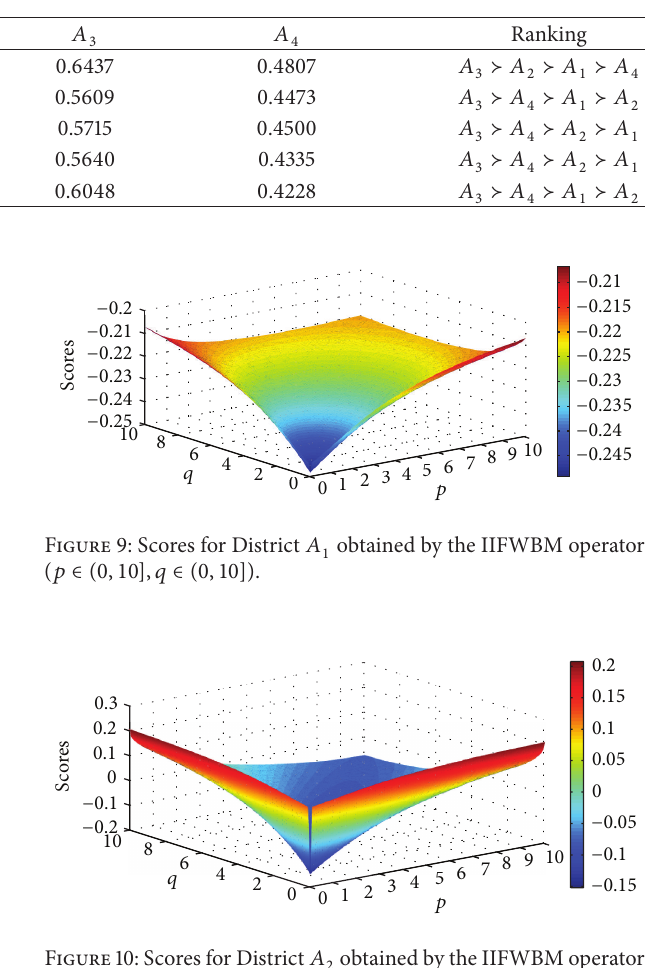
Figure 10: Scores for District 𝐴 2 obtained by the IIFWBM operator (𝑝 ∈ (0, 10],𝑞 ∈ (0, 10])